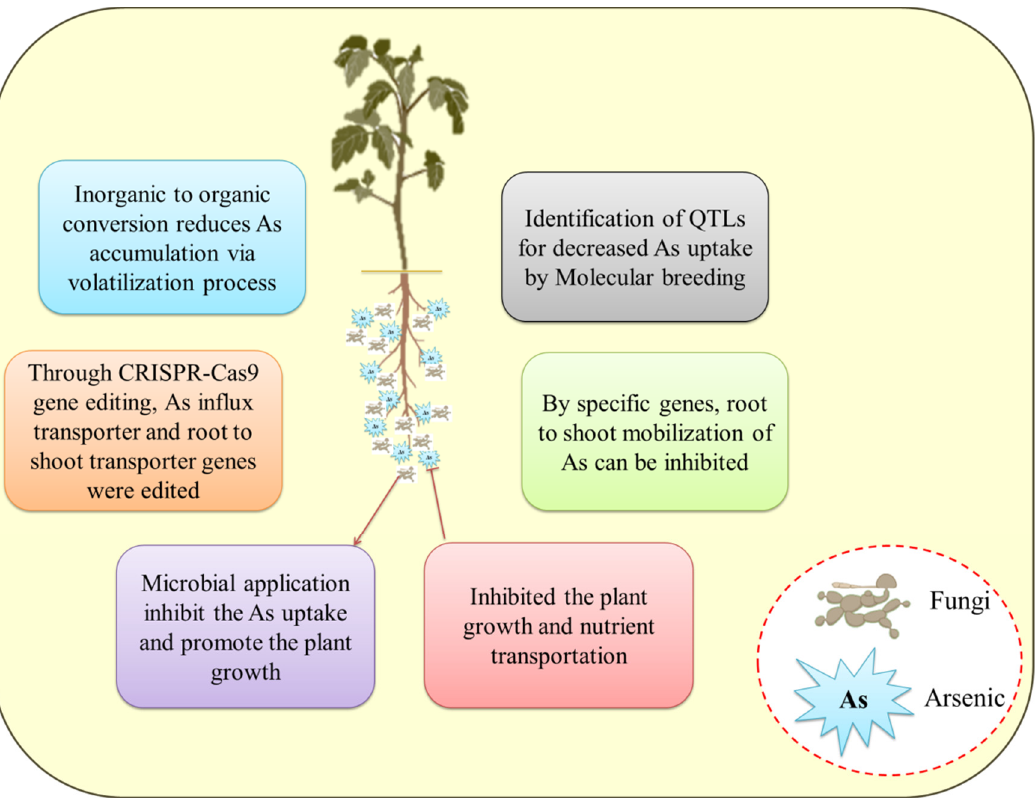
Figure 3. Arsenic reduction through biotechnological interventions in various crops.